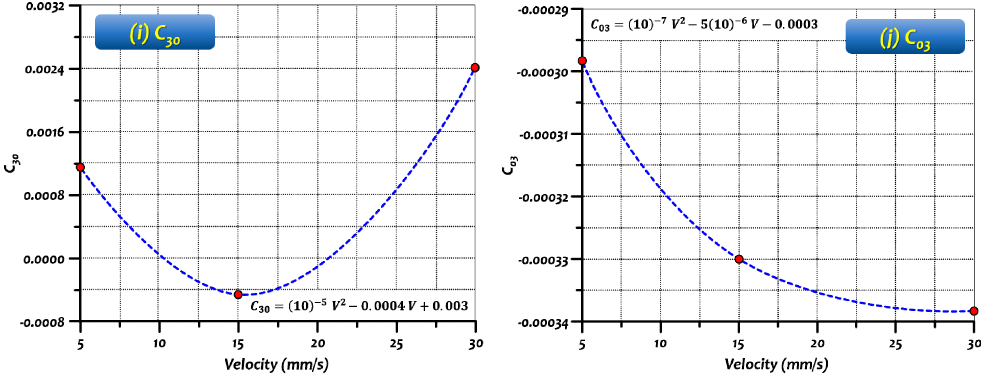
Figure 21. Interpolations of the coefficients of the proposed equation ( a ) C 00 , ( b ) C 10 , ( c ) C 01 , ( d ) C 20 , ( e ) C 02 , ( f ) C 11 , ( g ) C 21 , ( h ) C 12 , ( i ) C 30 , and ( j ) C 03.